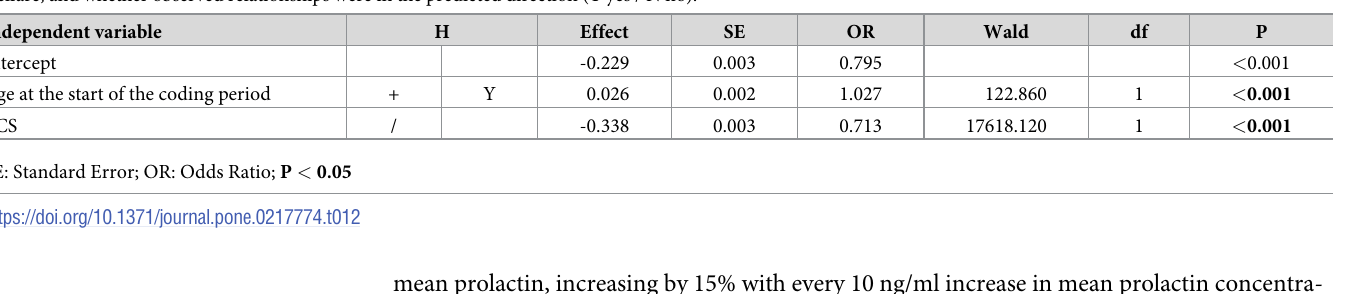
Table 12. Multivariate assessment of the occurrence of skin lesions by binomial regression, counting each animal as having experienced (n = 77) or not (n = 135) this type of pathology. Hypotheses (H): positive (+) or negative (-) relationship of each variable with the occurrence of clinical events per animal as a measure of elephant welfare, and whether observed relationships were in the predicted direction (Y yes / N no).